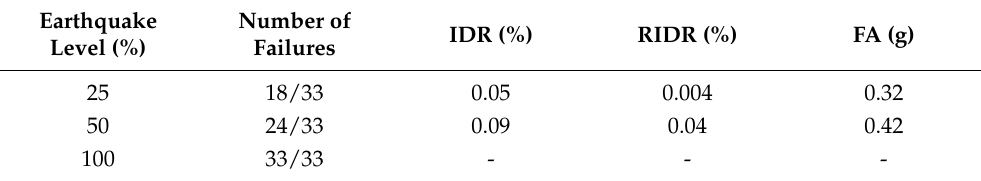
Table 6. Number of failures and peak IDR, RDIR, FA values-case (i): flexural and shear hinges. Earthquake